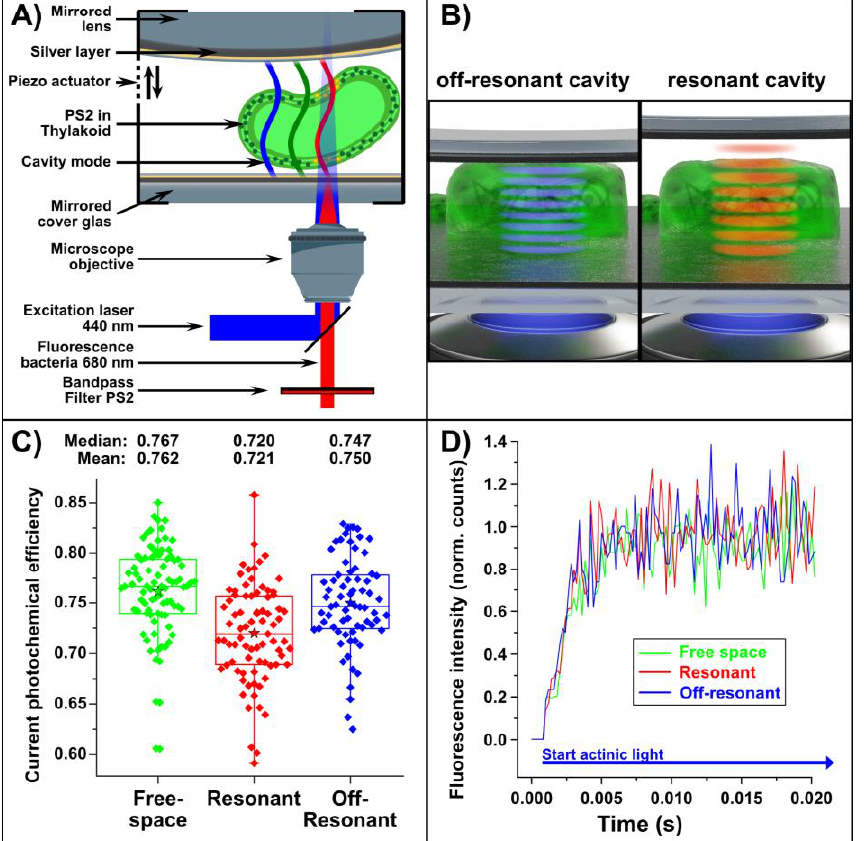
Figure 3. ( A ) Layout of the experimental set-up. A laser (440 nm, continuous wave) is focused by an objective lens onto a single bacterium in the microcavity that consists of two semi-transparent silver mirrors. The fluorescent light of the bacterium is transmitted by the beam splitter and directed to a detector. ( B ) Illustration of S. elongatus in a microcavity (consisting of two very close silver mirrors). On the right, bacterial fluorescence is resonant with the microcavity mode (red waves), which leads to strong coupling and splitting of the energy levels. For detailed measurements, please refer to: [8]. On the left, S. elongatus is illustrated in an off-resonant microcavity. ( C ) Box plot of the quantum yield of S. elongatus in free space (green dots), in a resonant (red dots) and an off-resonant (blue dots) microcavity. The quantum yield drops significantly inside the resonant microcavity (two-tailed t -test: compared to free space: p = 7.54 × 10 − 8 ; compared to off-resonant microcavity: p = 1.52 × 10 − 4 ), with otherwise equal ambient conditions in both series of measurements. Statistically, the free space and off-resonant measurement series do not differ (two-tailed t -test, p = 0.12). ( D ) Three representative fluorescence curves (normalized to F M ) of cyanobacteria in free space (green curve), in a resonant microcavity (red curve) and an off-resonant cavity (blue curve). The star in ( C ) represents the